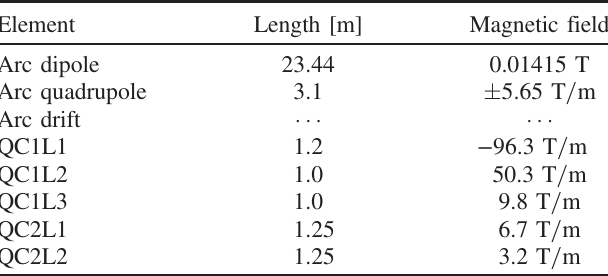
TABLE II. Magnet parameters used for build up simulations at 45.6 GeV.